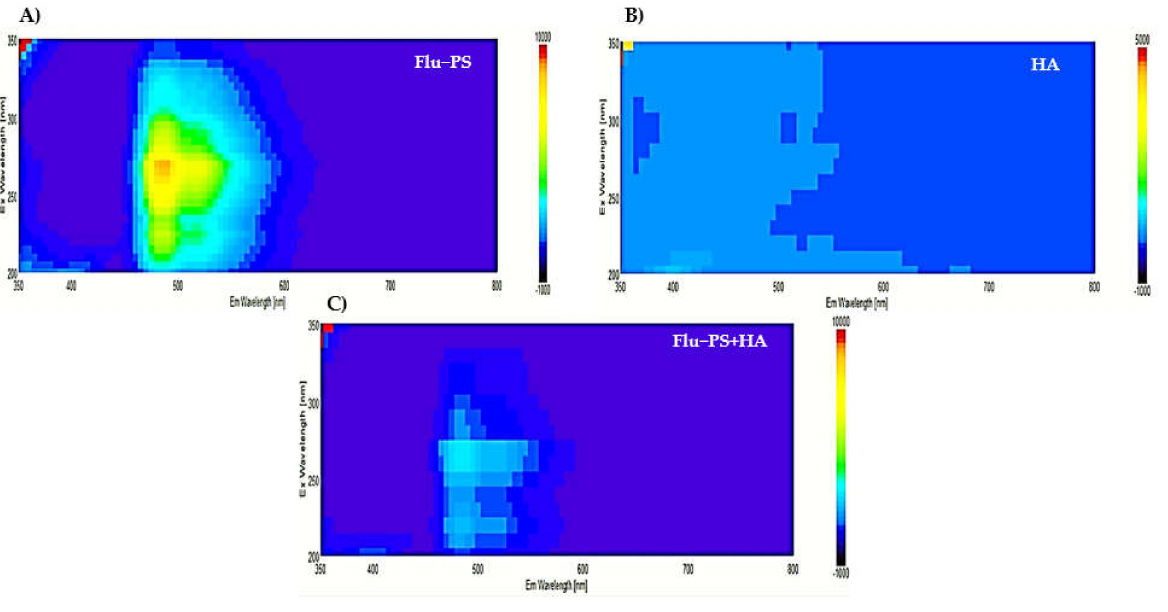
Figure 3. The3D Fluorescence spectroscopy observation pattern images of ( A ) Flu − PS, ( B ) HA, and ( C ) Flu −